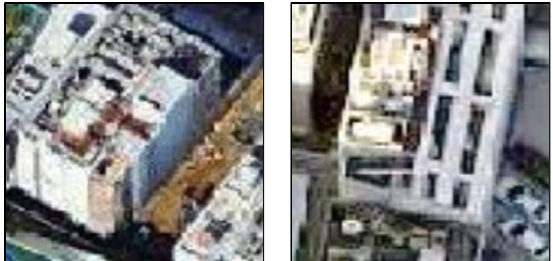
Figure 12. Example of detached office images estimated as detached offices